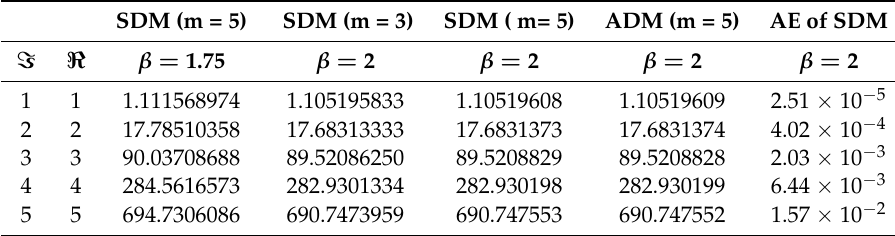
Table 2. Comparison of SDM and ADM [42] of Example 1 at τ =